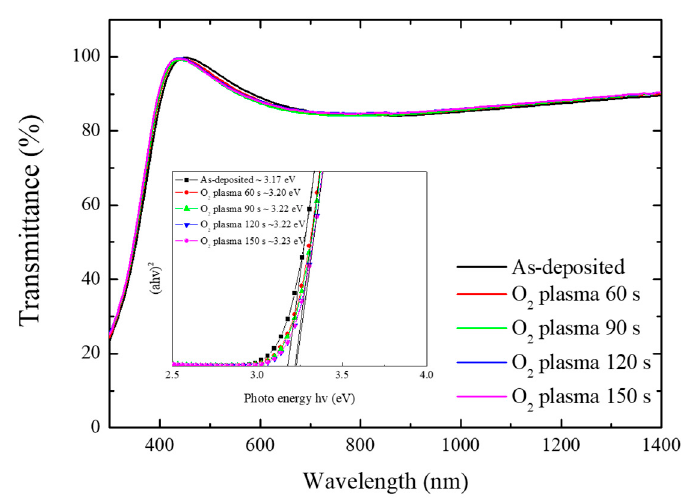
Figure 2. The optical transmittance spectra as a function of O 2 plasma treatment time for the Zn 0.6 Sn 0.4 O thin films. In the insert, the magnified spectra of the Zn 0.6 Sn 0.4 O thin films and the bandgap of Zn 0.6 Sn 0.4 O.